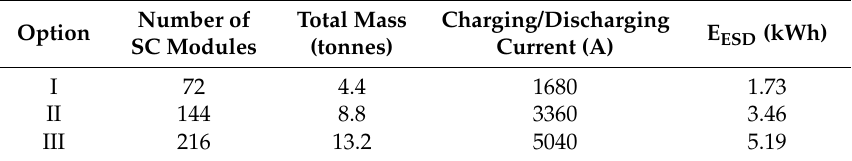
Table 3. ESD parameters for train.